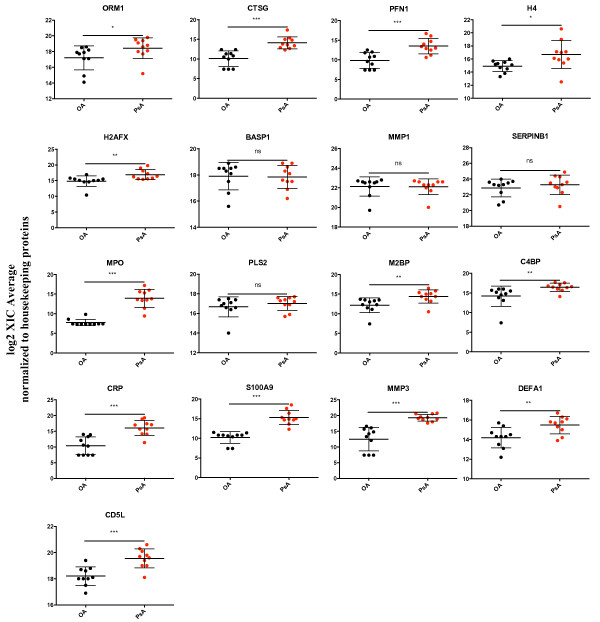
Verification of elevated proteins in PsA synovial fluid (Set I) by selected reaction monitoring assays, normalized against housekeeping proteins. Symbols represent SF samples from individual subjects; horizontal lines depict the mean, and vertical lines the standard deviation. ****Indicates P < 0.0001; ***P < 0.001; **P < 0.01; *P < 0.05; ns: non-significant.